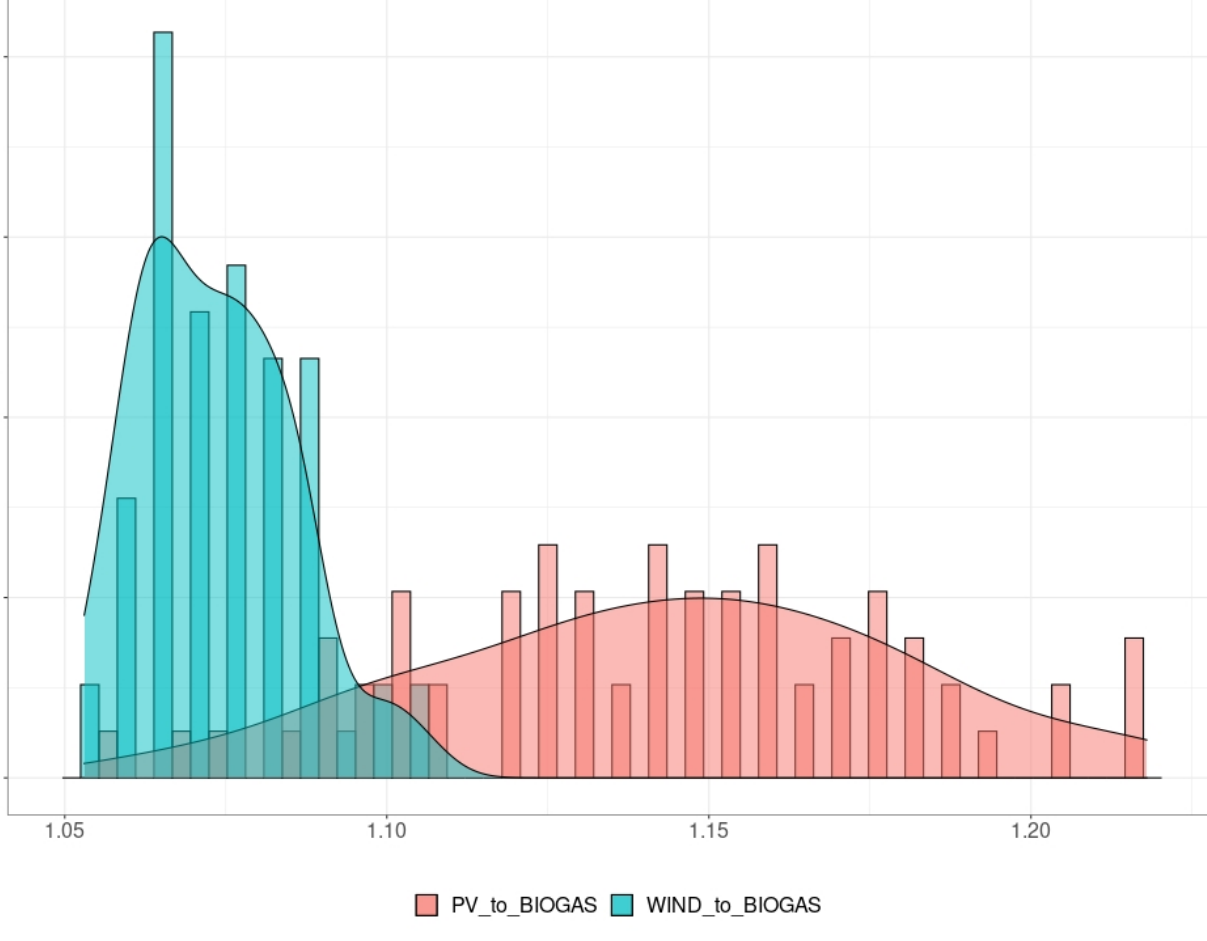
Figure 1. Distribution of the capacity quotient for individual types of generating sources.